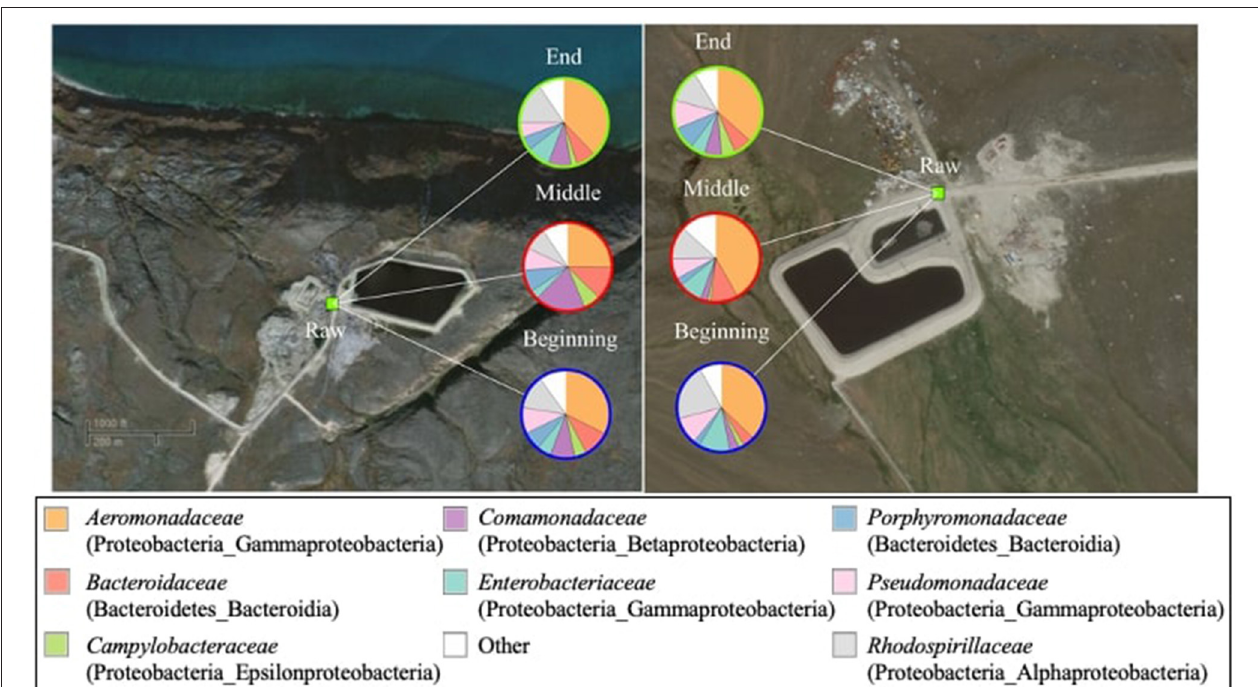
FIGURE 3 | Composition of the core bacterial community (family level) in raw wastewater samples ( n = 34 in total) from Pond Inlet (left) and Clyde River (right) obtained in 2013–2014. The relative abundances of bacterial families (top eight of 18 families) are shown in the pie charts. Legends on top of the pie charts (Beginning, Middle, and End) indicate the sampling time. Bacterial families and their associated phylum and class names are listed in brackets. Other: sum of bacterial families with relative abundances below 10%.